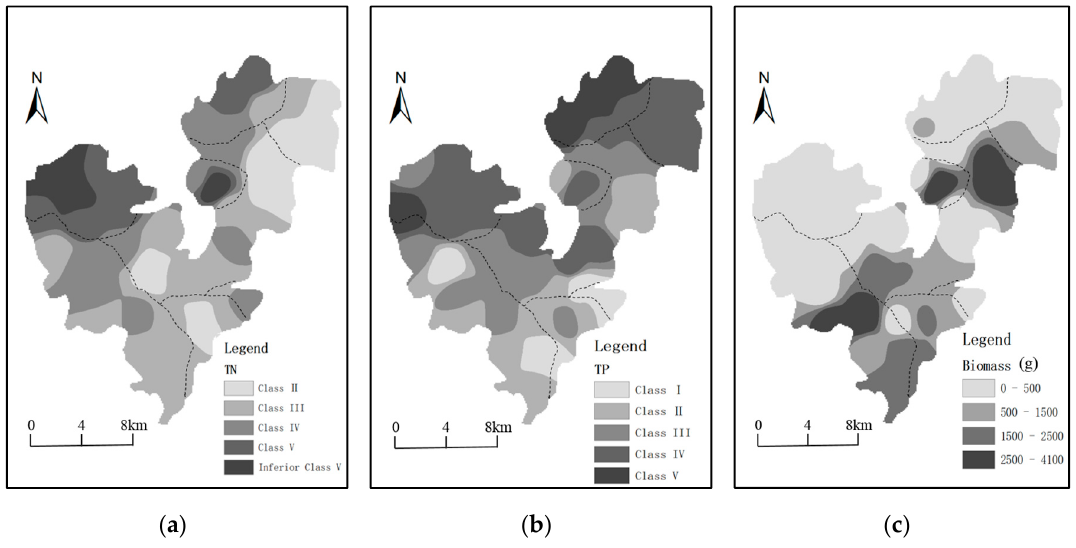
Figure 6. Spatial variability in TN, TP and biomass in the wet season: ( a ) TN; ( b ) TP; and ( c ) Biomass.